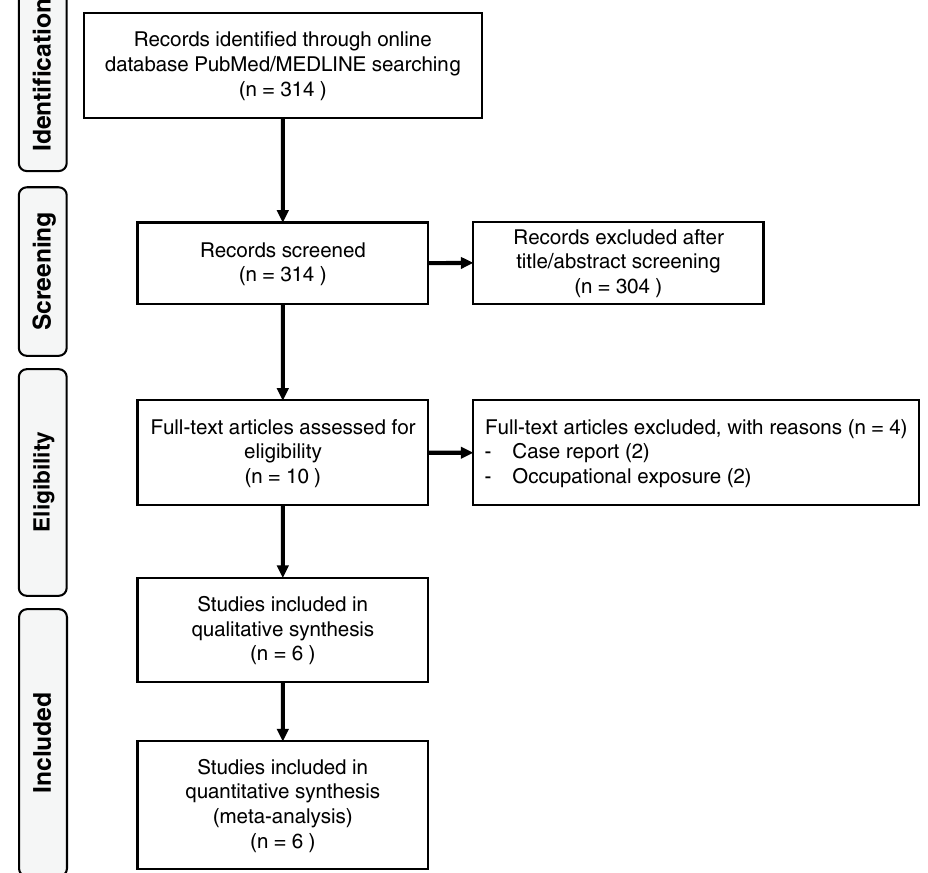
Figure 1. PRISMA flow-chart for study identification and